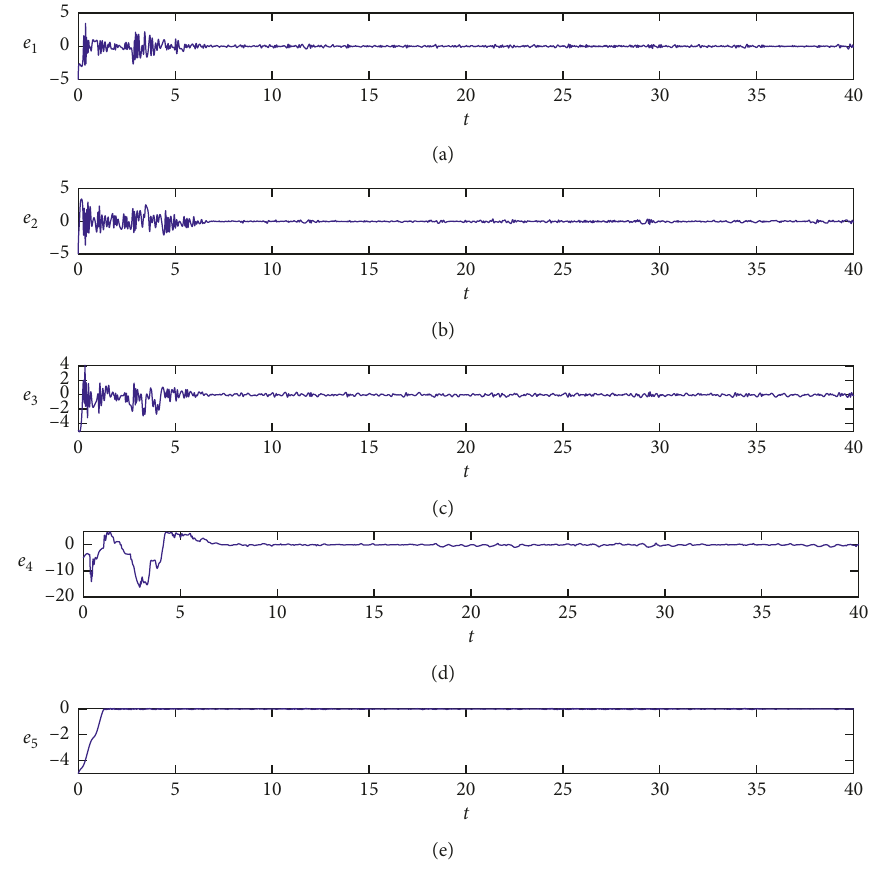
Figure 10: The trajectories of the synchronization errors e